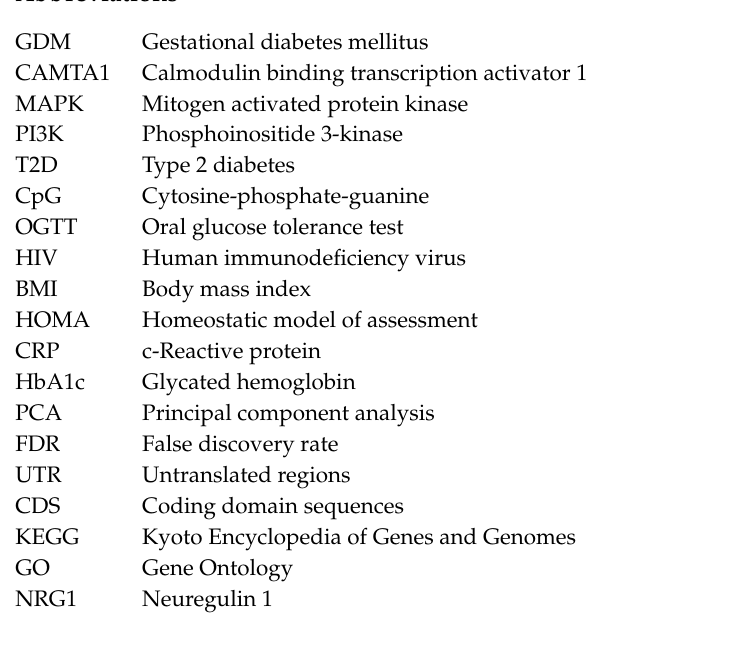
distribution, Figure S3: Venn diagram illustrating comparison of di ff erentially methylated genes, Figure S4: Comparison of six major peripheral blood cell components in GDM and non-GDM women, Table S1: Genome-wide DNA methylation profiling identified 1046 di ff erentially methylated CpG loci, Table S2: Di ff erentially methylated CpG sites annotated to 939 unique genes, Table S3: Univariate and multivariate linear regression analysis, Table S4: Functional enrichment analysis identified 261 Kyoto Encyclopedia of Genes and Genomes (KEGG) pathways, Table S5: Statistically significant KEGG pathways associated with GDM, Table S6: GO terms enriched by di ff erentially methylated genes, categorized into 1181 biological processes, 167 molecular functions and 85 cellular